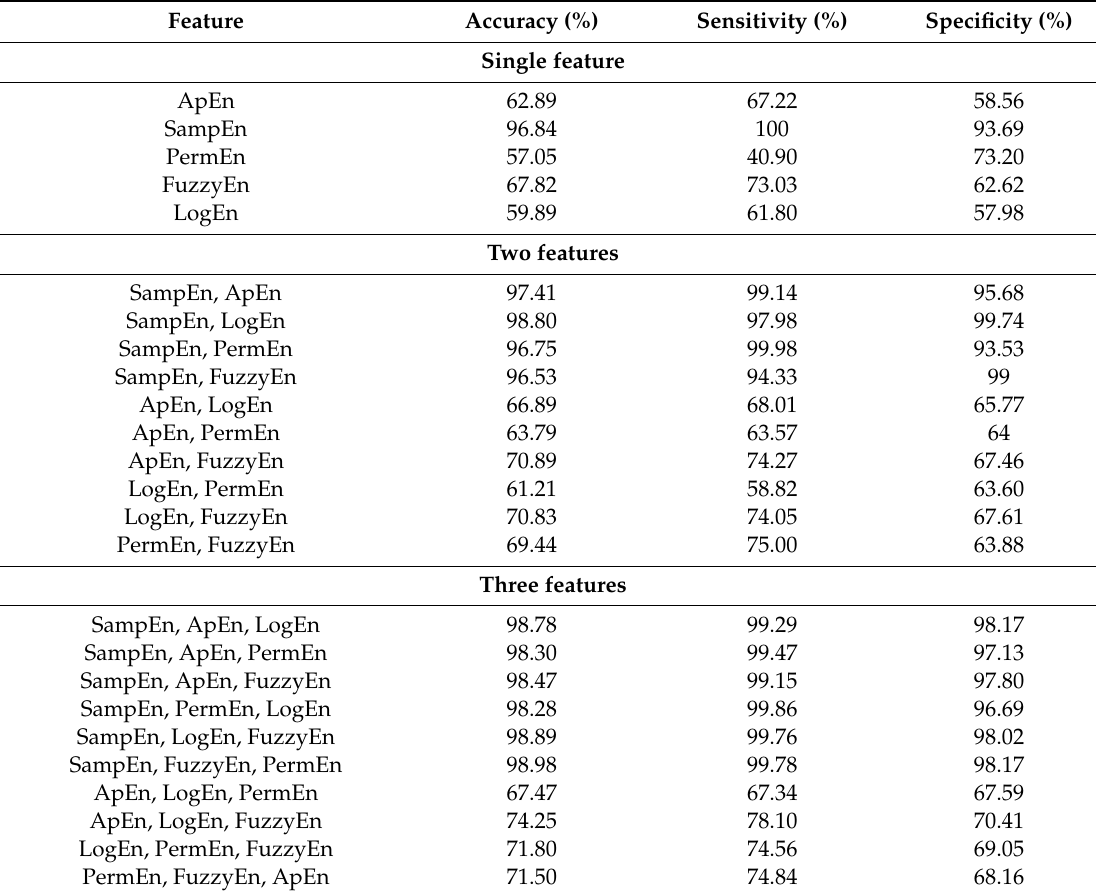
Table 1. The classification results using the combination of entropy features for the Bern-Barcelona (BB)